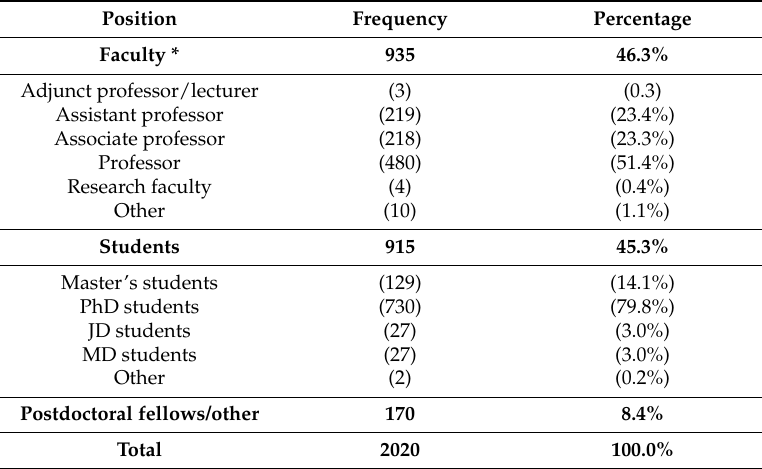
Table 1. Demographics: positions of